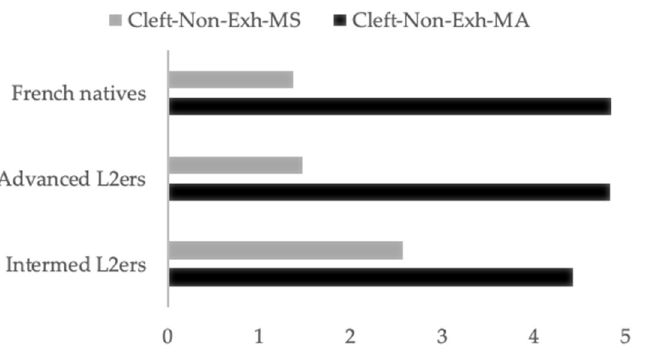
Figure 6. Average ratings for clefted questions in the non-exhaustive picture condition, per answer type and proficiency.